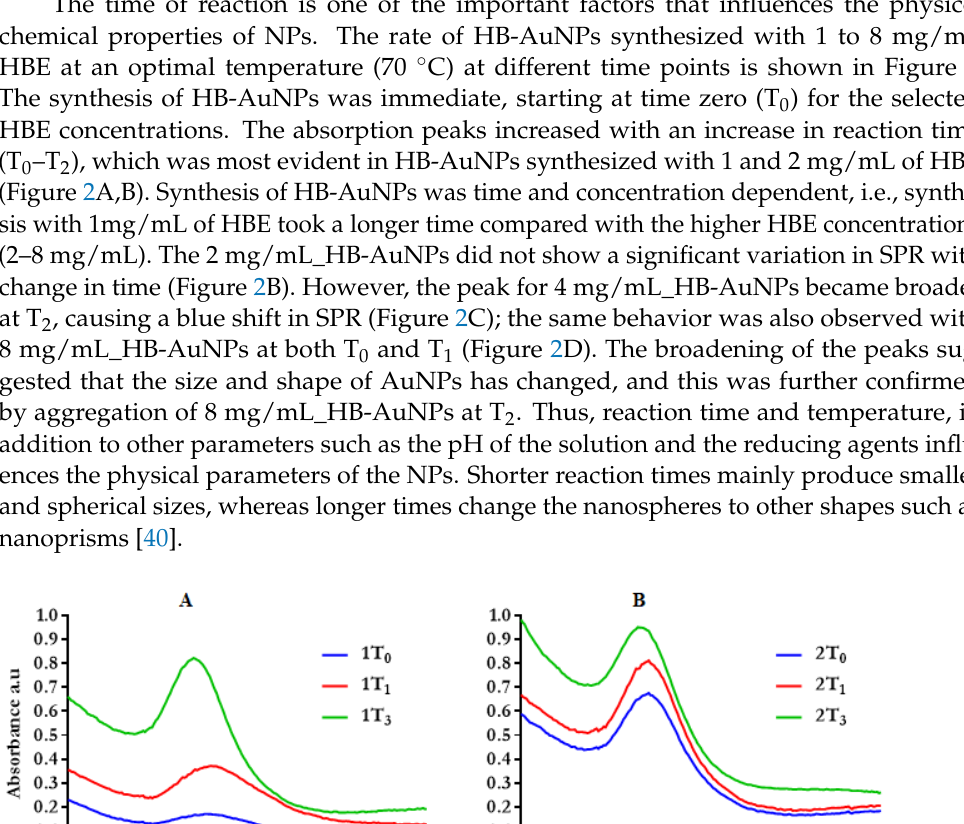
Figure 1. Synthesis of HB-AuNPs using different concentrations of HBE at 25 °C ( A ) and 70 °C ( B ).